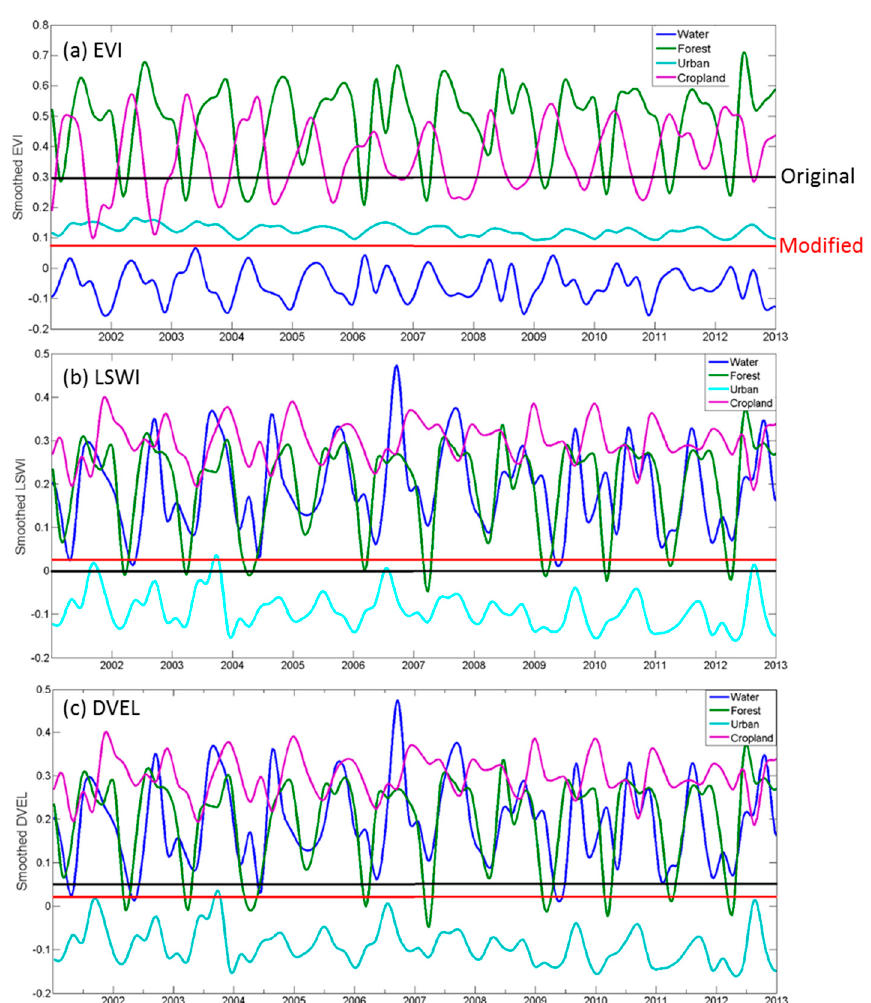
Figure 3. Smoothed ( a ) Enhanced Vegetation Index (EVI), ( b ) Land Surface Water Index (LSWI) and ( c ) difference between EVI and LSWI (DVEL) of four land cover types with threshold values in the original WFFI and modified WFFI (black and red line, respectively).